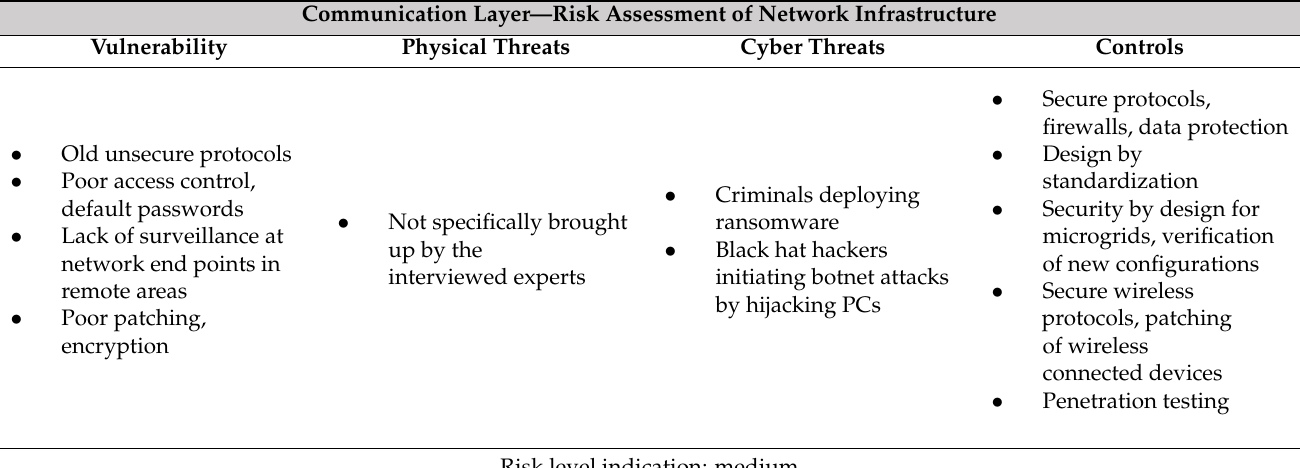
Table 9. Risk assessment for network